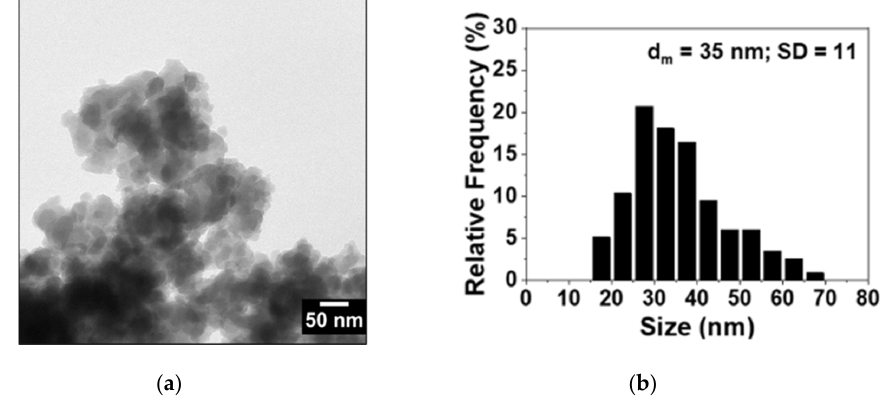
Figure 3. Representative TEM micrograph ( a ) and histogram of particles size distribution ( b ) of the PB_Syn sample.